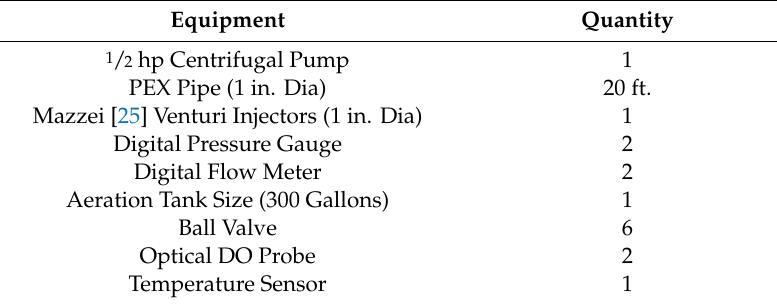
Figure 2. Experimental Setup at the University of Alabama. Table 1. List of experimental equipment.